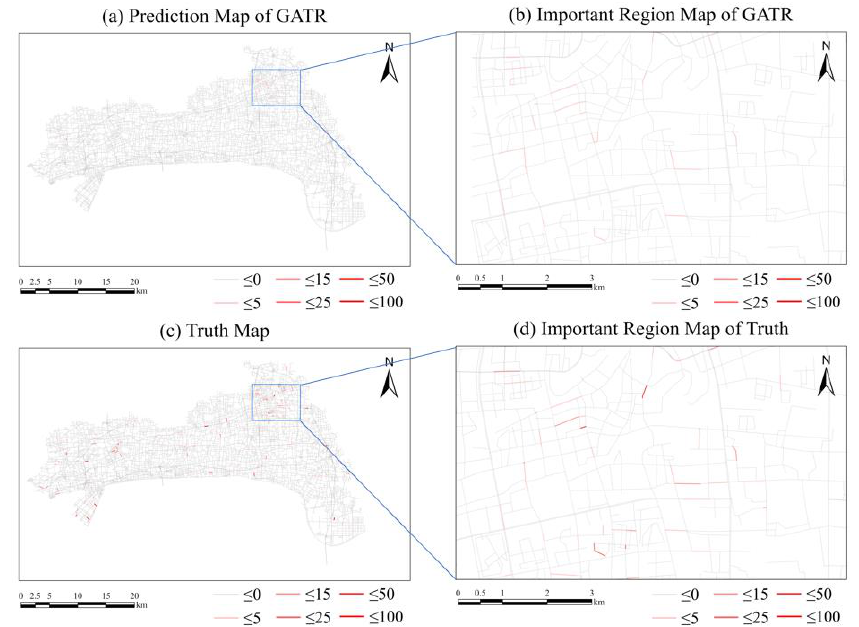
Figure 10. Comparison between the predicted result using GATR and the truth. ( a ) Predicted result of traffic violations using GATR. ( b ) Important region map of GATR. ( c ) Truth values of traffic violations. ( d ) Important region truth values of traffic